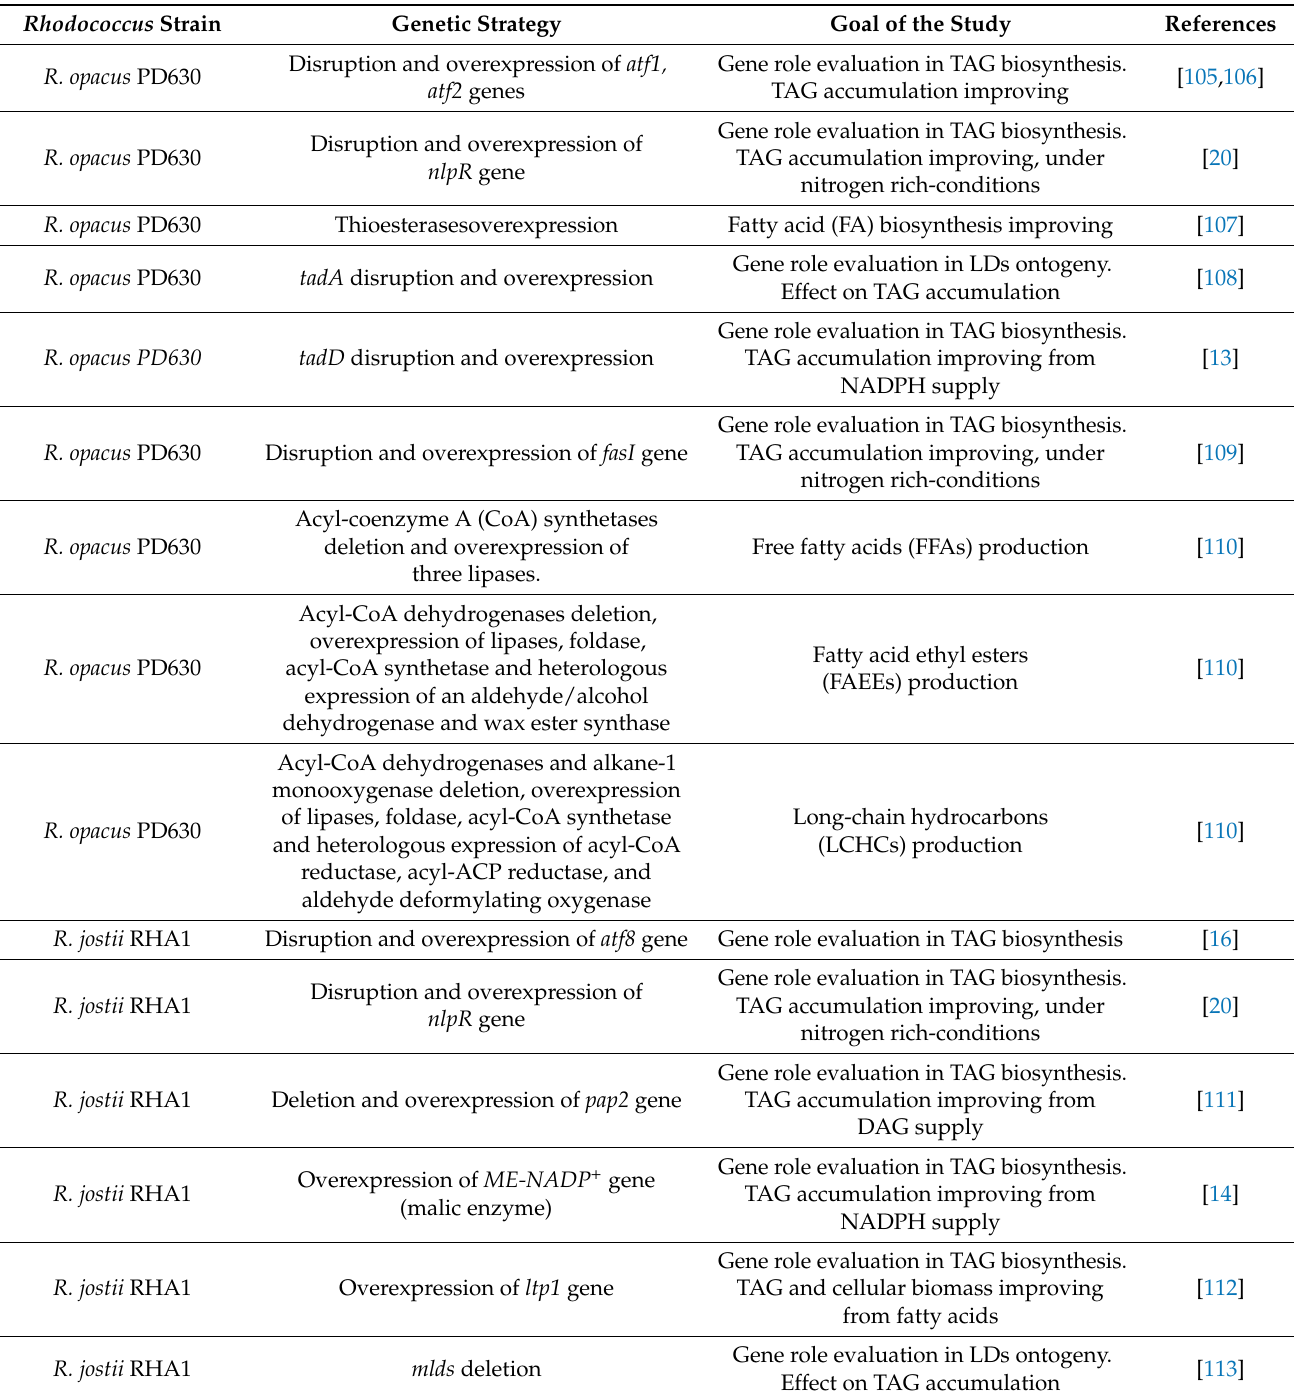
Table 3. Main genetic strategies applied in oleaginous Rhodococcus for TAG and other lipids improvement. Rhodococcus